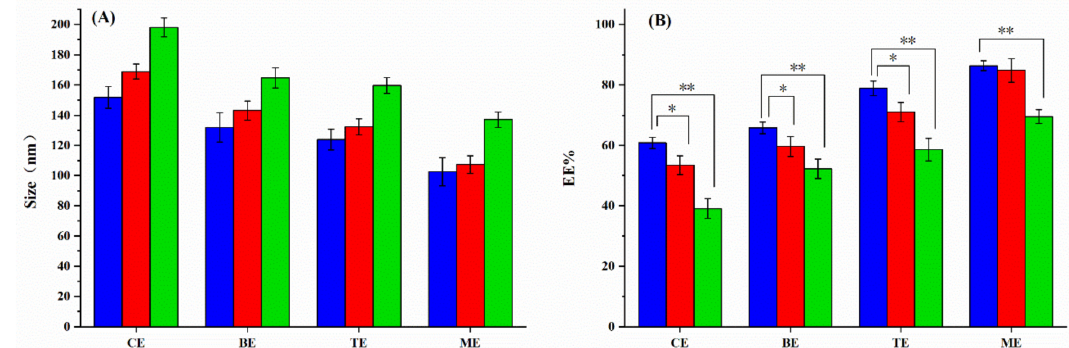
Figure 2. Stability investigation of the formulations after 60 days storage. ( A ) Particle size of di ff erent formulations before (blue) and after 60-day storage at 4 (red) or 25 ◦ C (green); ( B ) EE of di ff erent formulations before (blue) and after 60-day storage at 4 (red) or 25 ◦ C (green). Data are shown as the mean ± SD ( n = 3). * P < 0.05, ** P <